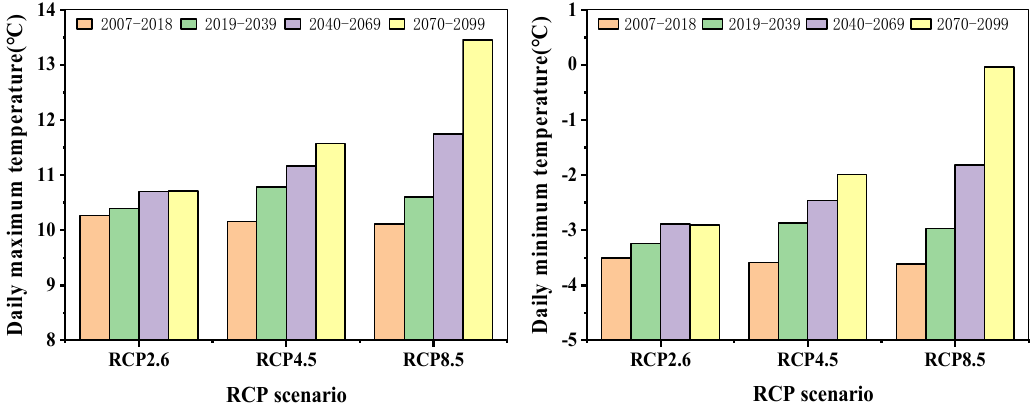
Figure 4. The future changes in the maximum and minimum temperatures under different scenarios. The maximum temperature and minimum temperature show increasing trends under the three scenarios. The change in the maximum temperature under the RCP2.6 scenario increases steadily, and the increments in the three stages would be 0.13 ◦ C, 0.44 ◦ C, and 0.44 ◦ C higher than those from 2007 to 2018, which is consistent with the change trends in the average temperature. Under the RCP4.5 scenario, the maximum temperature would increase significantly, and the temperature could be 0.63 ◦ C, 1.02 ◦ C, and 1.42 ◦ C higher than in 2007–2018, under the three scenarios, with a maximum change range of 13–17%. The future maximum temperature shows significant changes under the RCP8.5 scenario, which would increase to 0.49 ◦ C, 1.64 ◦ C, and 3.34 ◦ C, which could be higher than the temperature in 2007–2018, with a maximum range of 33%. The results indicate that the highest temperature in the 21st century would increase gradually.